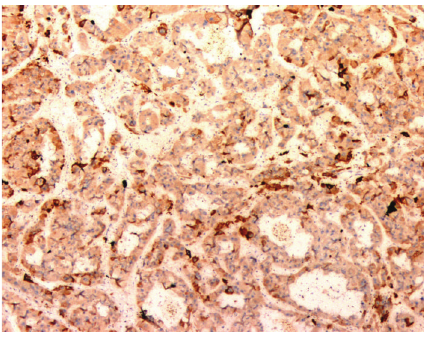
Figure 5: Tumor cells of HCC showing focal positivity for CK7, immunohistochemistry 100x.